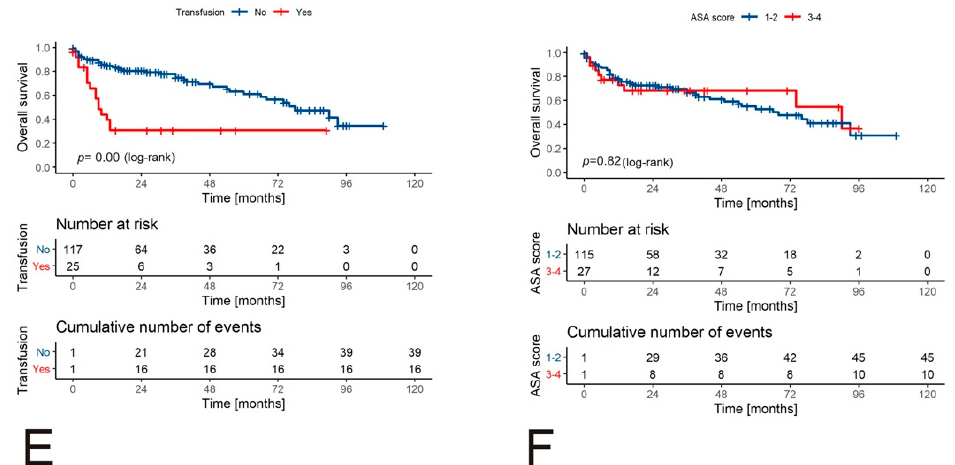
Figure 2. Survival of patients with RCC and tumor venous thrombus according to clinical variables.